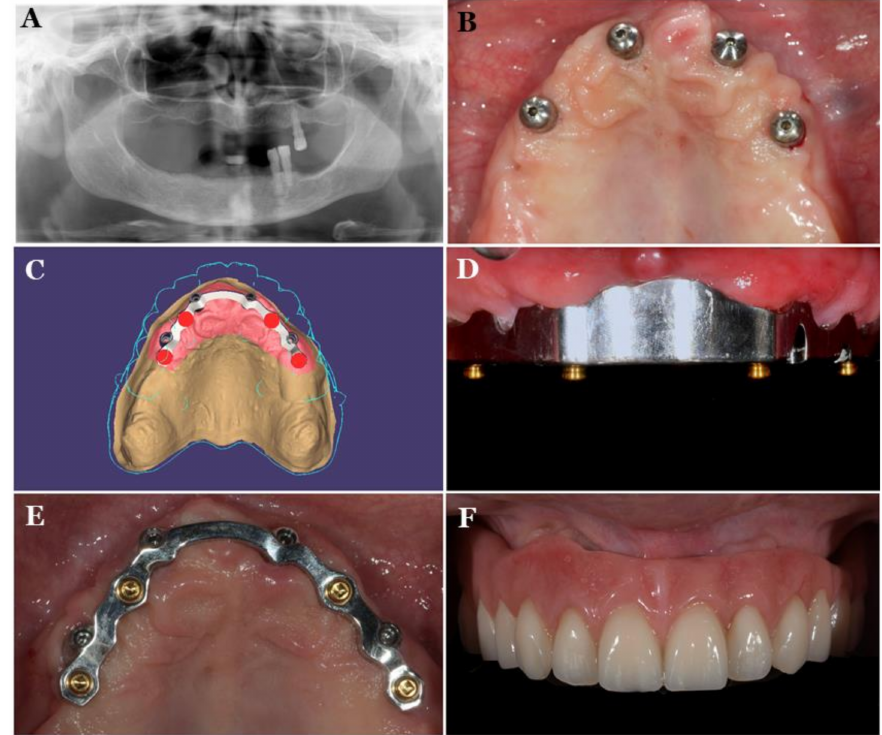
Figure 2. CAD/CAM titanium-bar-supported maxillary overdenture Pretreatment radiograph ( A ), 4 implants placed in maxillary arch ( B ), CAD design of the titanium bar ( C ), titanium bar inserted in the mouth ( D ), occlusal view of titanium bar ( E ), definitive prosthesis ( F )